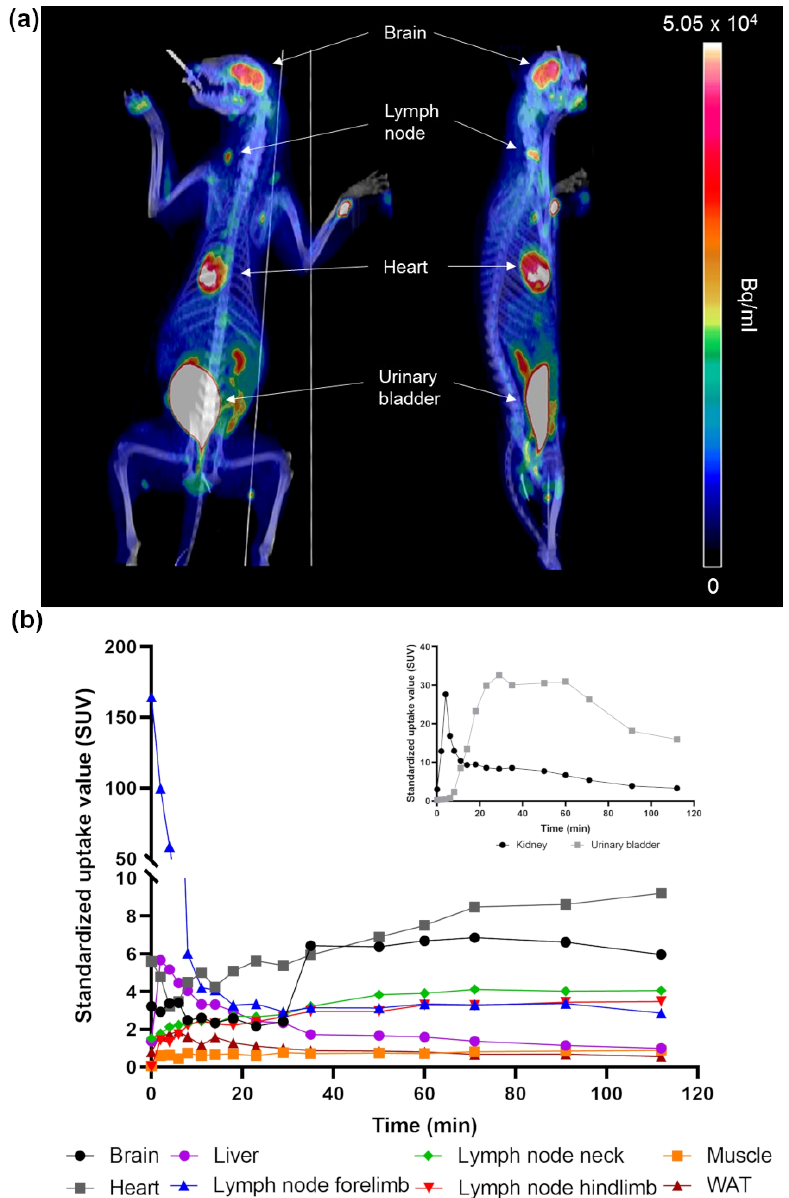
Figure 1. ( a ) Representative coronal and sagittal PET/CT images of one of the raccoon dogs. PET image represents an average radioactivity concentration during 120 min imaging. The highest radioactivity concentration is observed in brain, heart, urinary bladder, and lymph nodes in neck and forelimb. ( b ) Corresponding radioactivity concentration as a function of time from selected tissues. Table 1. Representative plasma glucose-corrected net influx rate (Ki) of 18 F-FDG uptake obtained by dy- namic PET and Patlak analysis (please see the method section for detailes) from one of the raccoon dogs. Organ K i (mL/mL·min) Brain